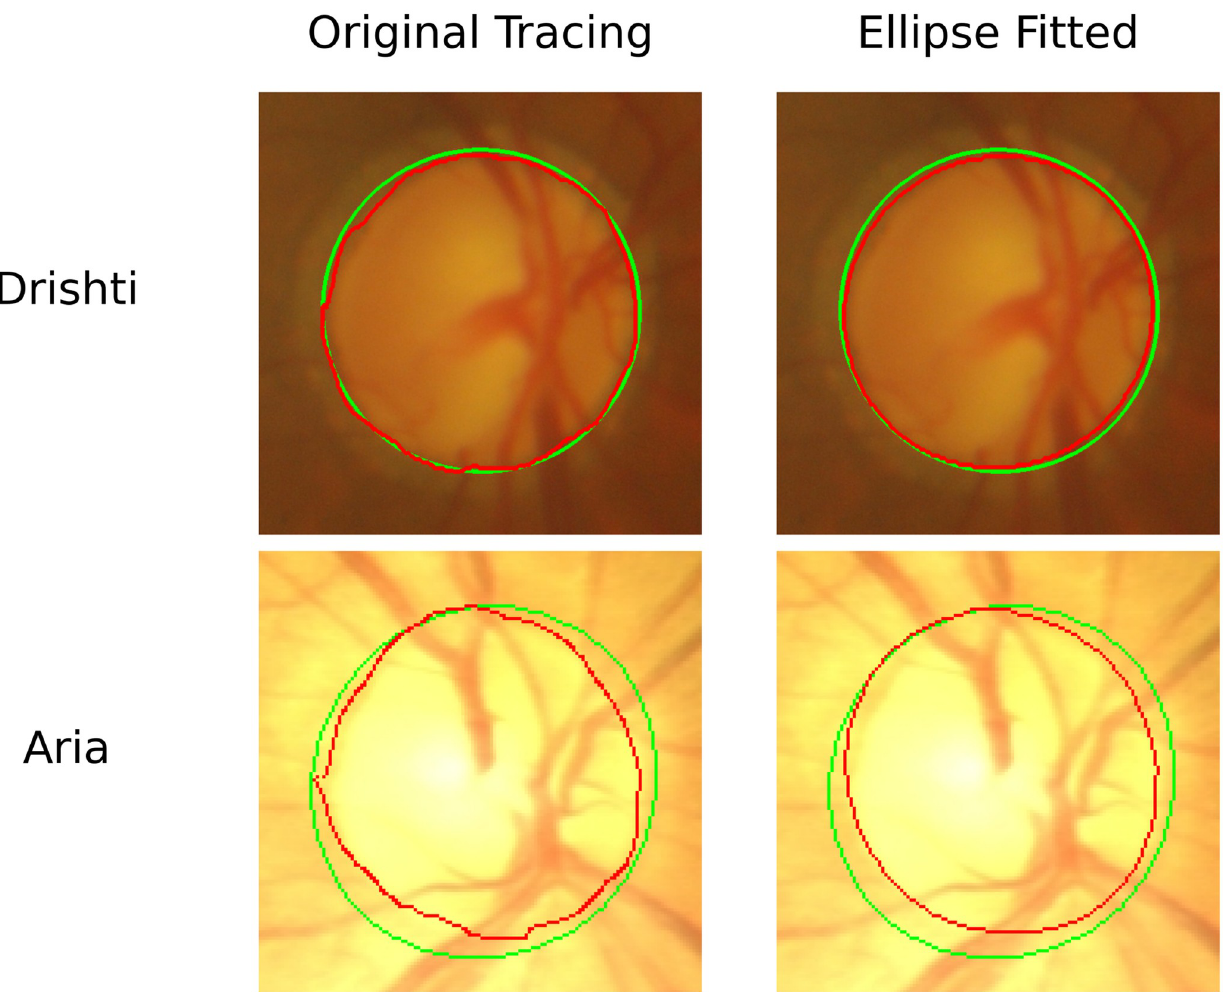
Fig 4. Images obtained from the Drishti and ARIA datasets showing improved disc tracing when ellipse fitting is applied. The first row represents an image from the Drishti dataset before and after applying ellipse fitting. The second row is similar to the first one but for an image obtained from the Aria dataset. The green tracing represents the ground truth and the red represents the tracing performed by the optometrist. The application of Ellipse fitting led to an increase of DC from 96.80% to 98.10% for the Drishti image from 95.60% to 96.10% for the Aria image.